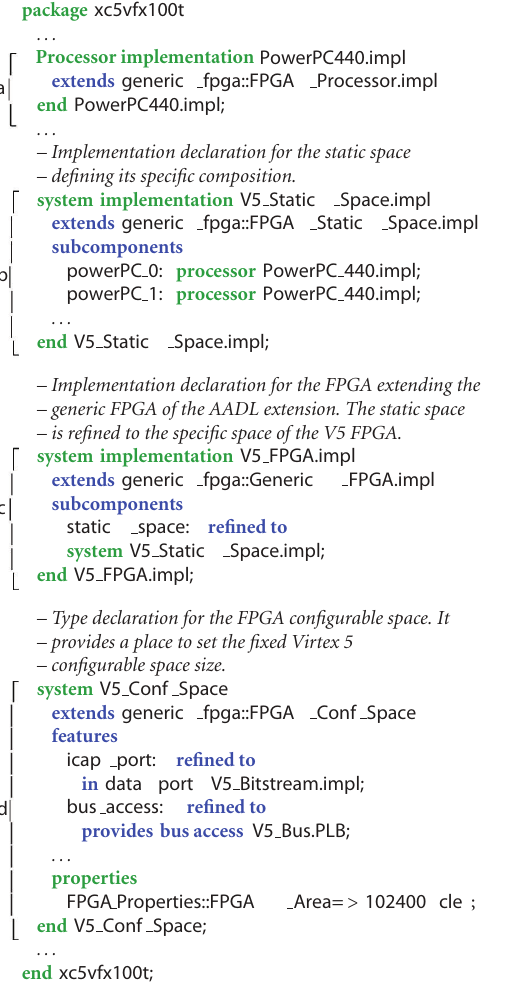
Figure 6: Part of the AADL description of the hardware platform specializing the AADL generic FPGA extension (some details are not given in this